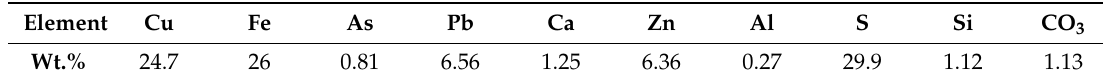
Table 2. Chemical analysis of the chalcopyrite concentrate.